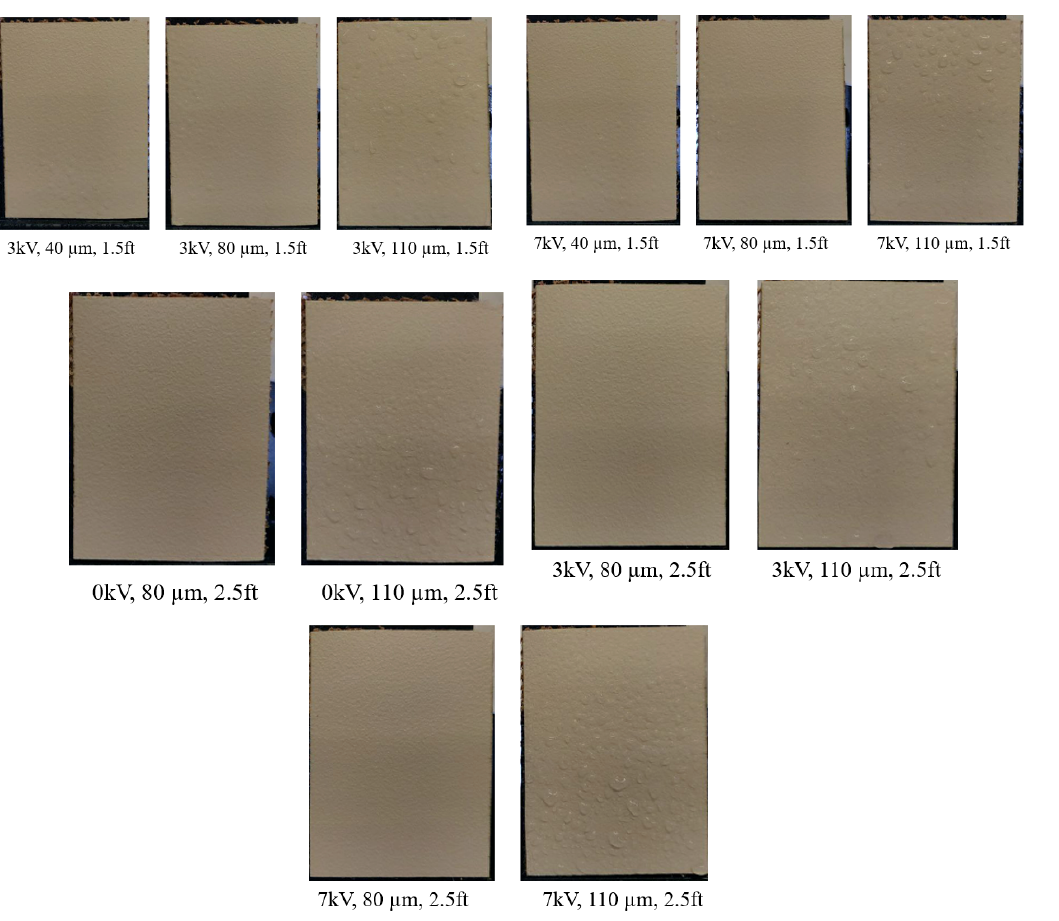
Figure A27. Aircraft sample-1: qualitative images of electrostatic deposition under various system